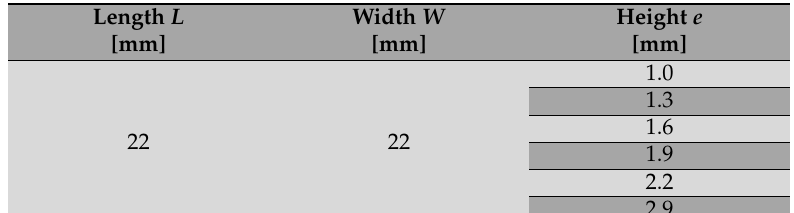
Table 2. Dimensions of VGs. Length L [mm]